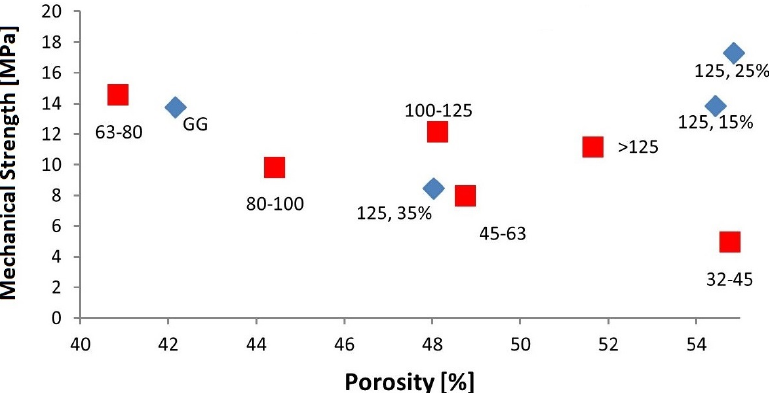
Figure 7. Mechanical strength and porosity of 3D-printed specimen.